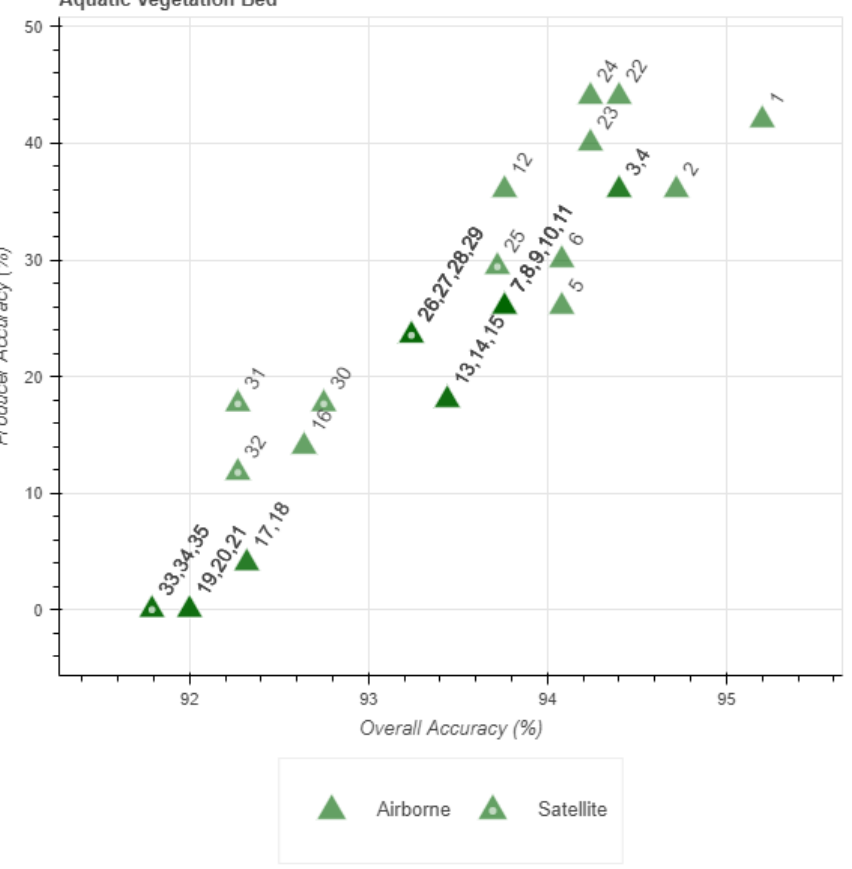
Figure 16. Tier 1 plot of aquatic vegetation bed classification performance, comparing percent overall accuracy and percent producer accuracy for airborne and satellite data combinations. Number labels refer to unique classification input data combinations identified in the Index field in Table A2, Appendix A.